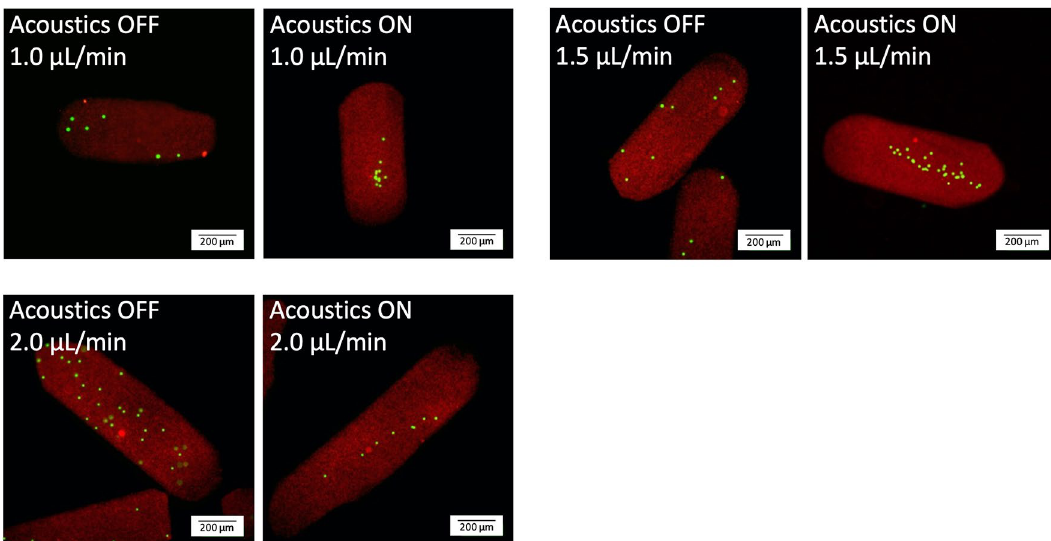
Figure 4. Acoustic focusing in different droplet lengths. The photos show the hydrogel droplets after cross- linking and washing. The flow rate of the oil was 1.5 µL/min while the flow rate of the hydrogel precursor solution was varied between 1.0 and 2.0 µL/min as indicated in the